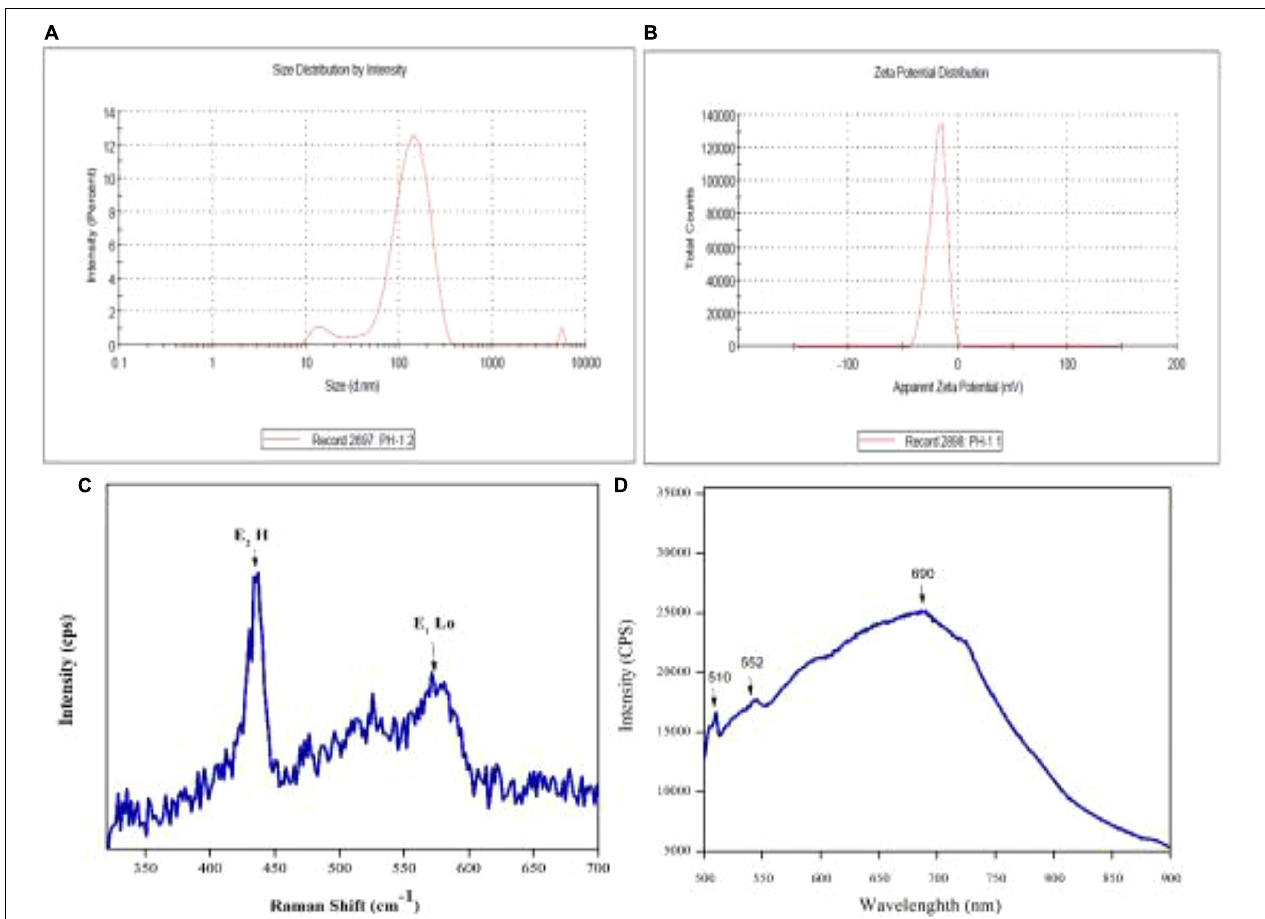
FIGURE 5 | (A) Size distribution of ZnO-NPs and (B) zeta potential of ZnO-NPs, (C) Typical Raman spectra of ZnO-NPs and (D) and room temperature PL.